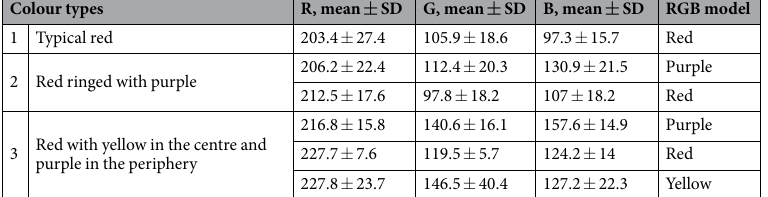
Table 2. Colour analysis and pixel brightness.